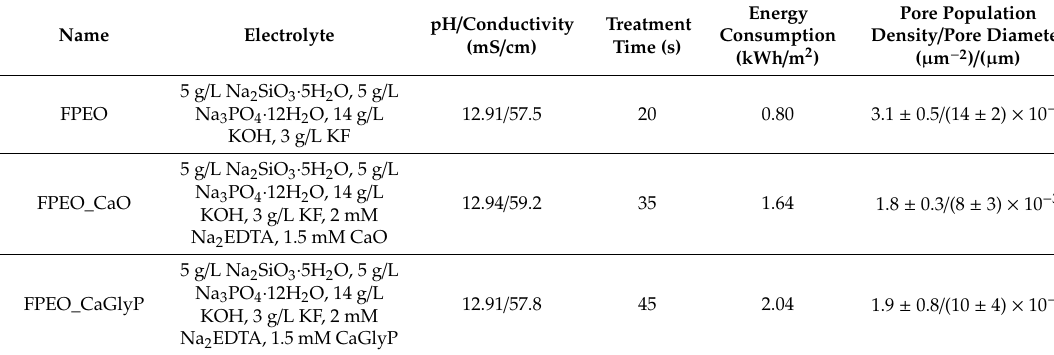
Table 3. Flash-PEO (FPEO) process and coating